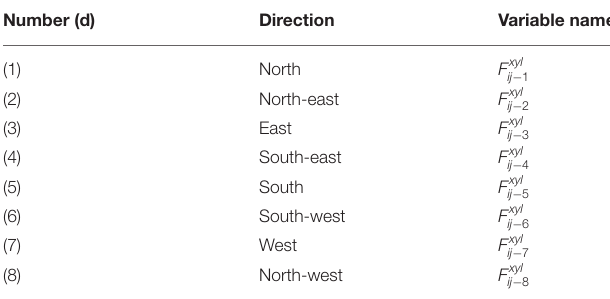
TABLE 1 | Xylem flux directions